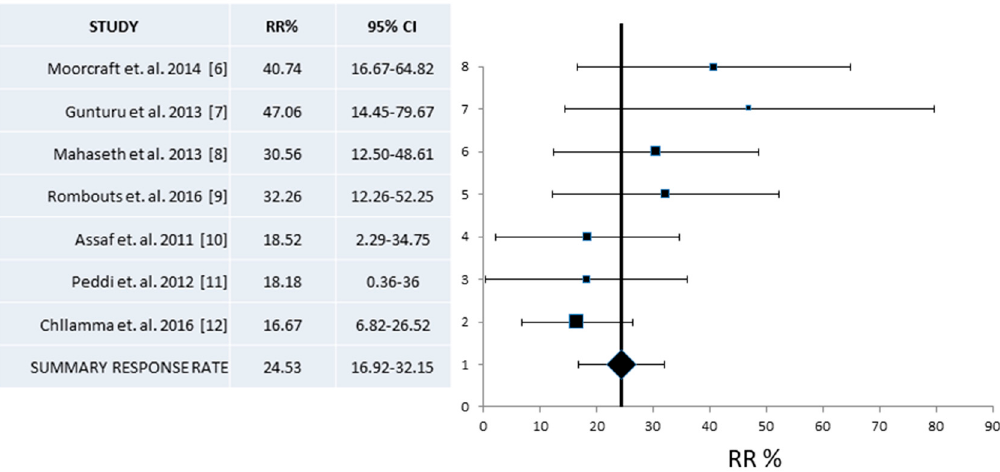
Figure 2. Pooled analysis of Response Rates (RR) and 95% Confidence Intervals (CI) from published series. Seven studies with a total of 229 patients that provided information for the RR were included and showed an overall RR of 24.5% (95% CI 16.9–32.1%).